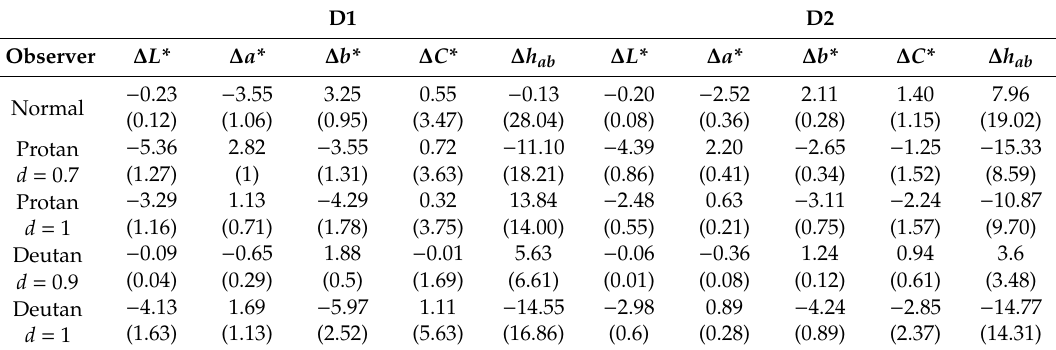
Table 4. Mean (standard deviation) of shifts in color coordinates when the selected best-performing filters were used by each simulated observer, and for both dataset D1 (Atlas) and D2 (scenes).